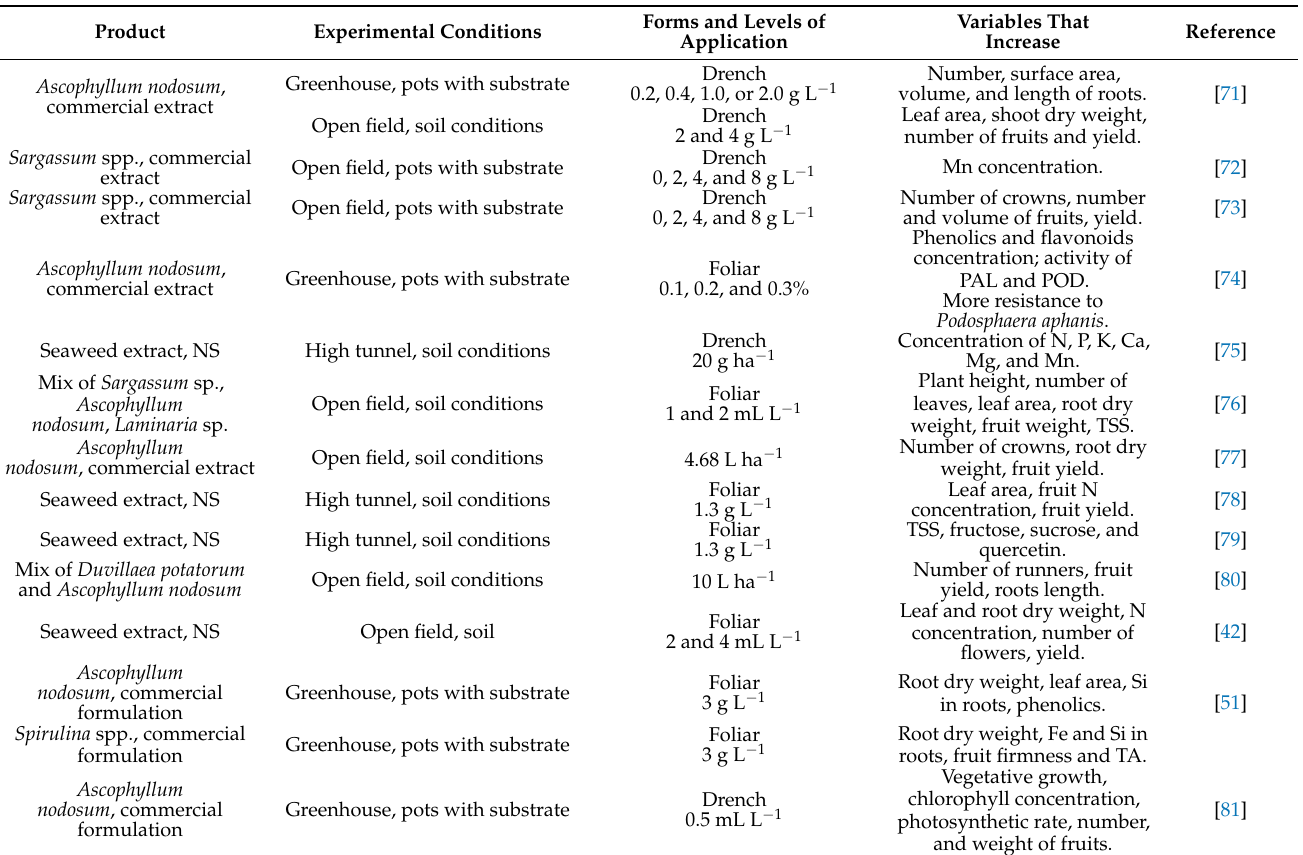
Table 3. Positive effects of seaweed and microalgal extracts on some growth or quality variables of strawberry